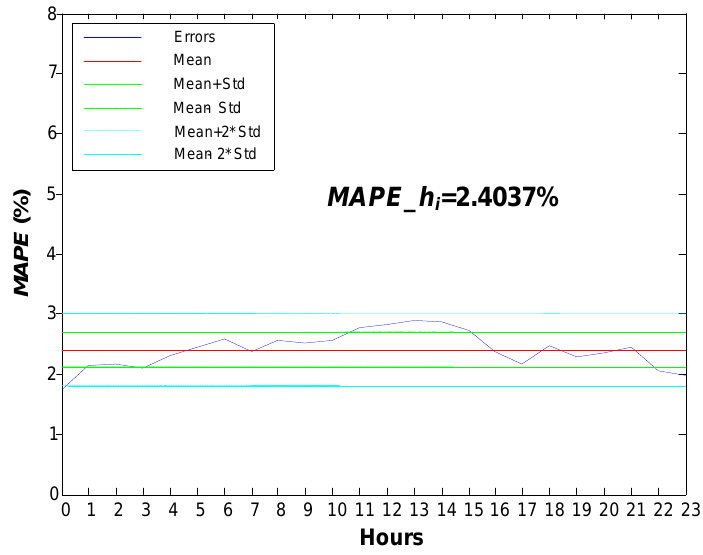
Figure 9. Errors per hour (without bad measures). In the x-axis are the 24 h. In the y-axis are the errors by Equation (3).